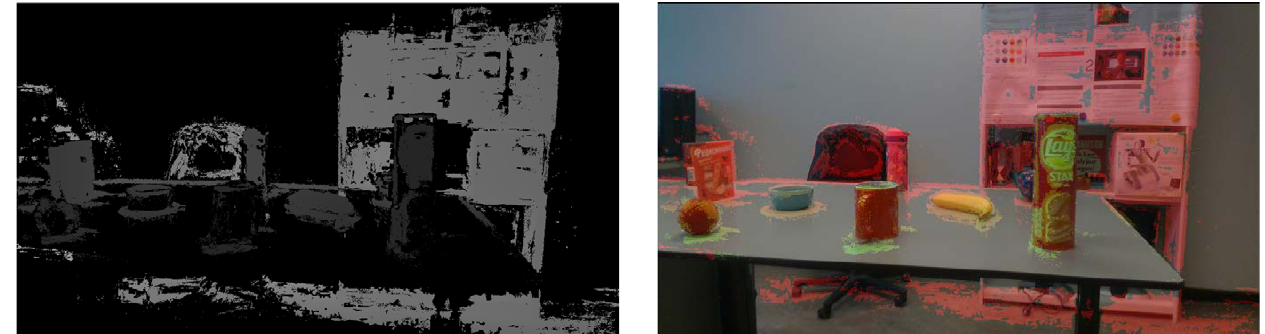
Figure 7. The depth images are estimated by COLMAP, showing better